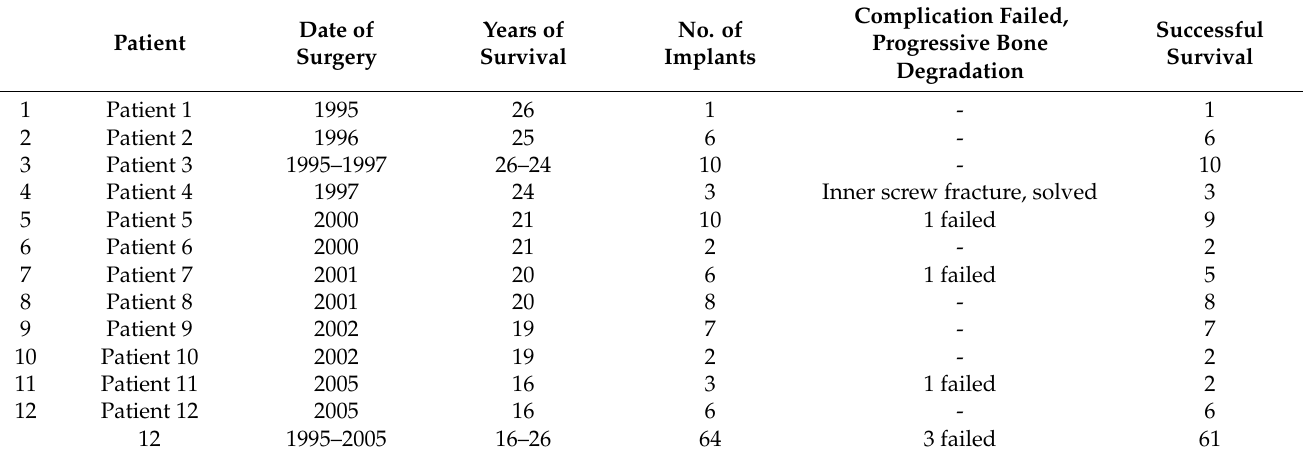
Table 1. Ti/TiO 2 implant